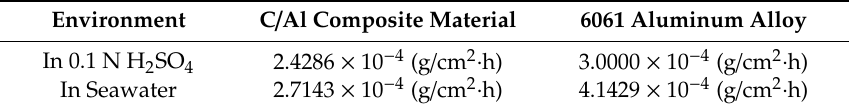
Table 2. Corrosion rate results from the immersion corrosion tests.